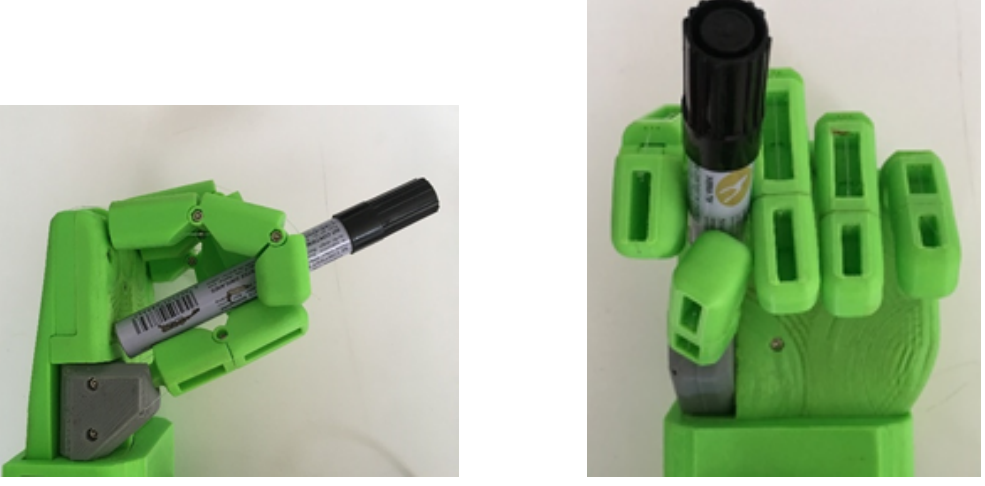
Figure 14. Centralized grip of the prosthesis while holding a